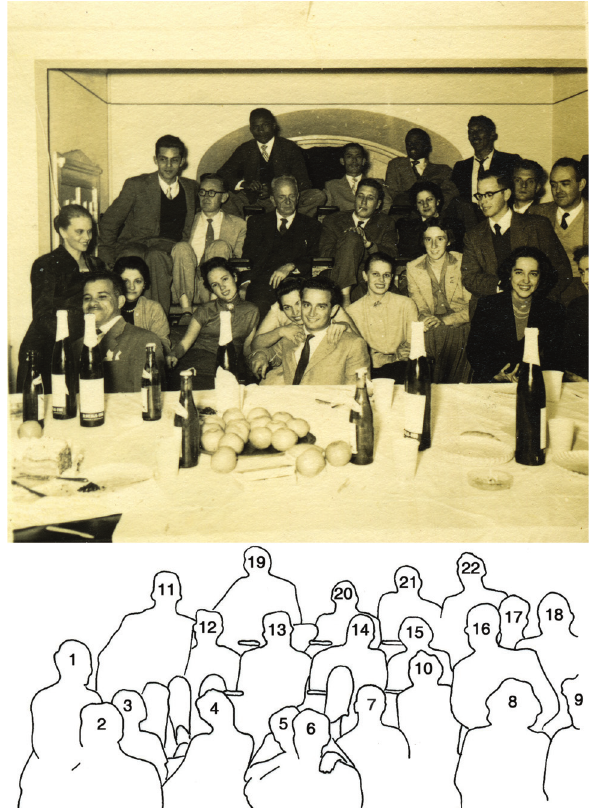
Figure 5 - Farewell party for Prof. Theodosius Dobzhansky, in July 1956, in the classroom for theoretical classes of the Departamento de Biologia Geral at the FFCL-USP, located in the right wing of the attic of the Jorge Street Mansion (archives of the first author). 1. Inger Frydenberg,